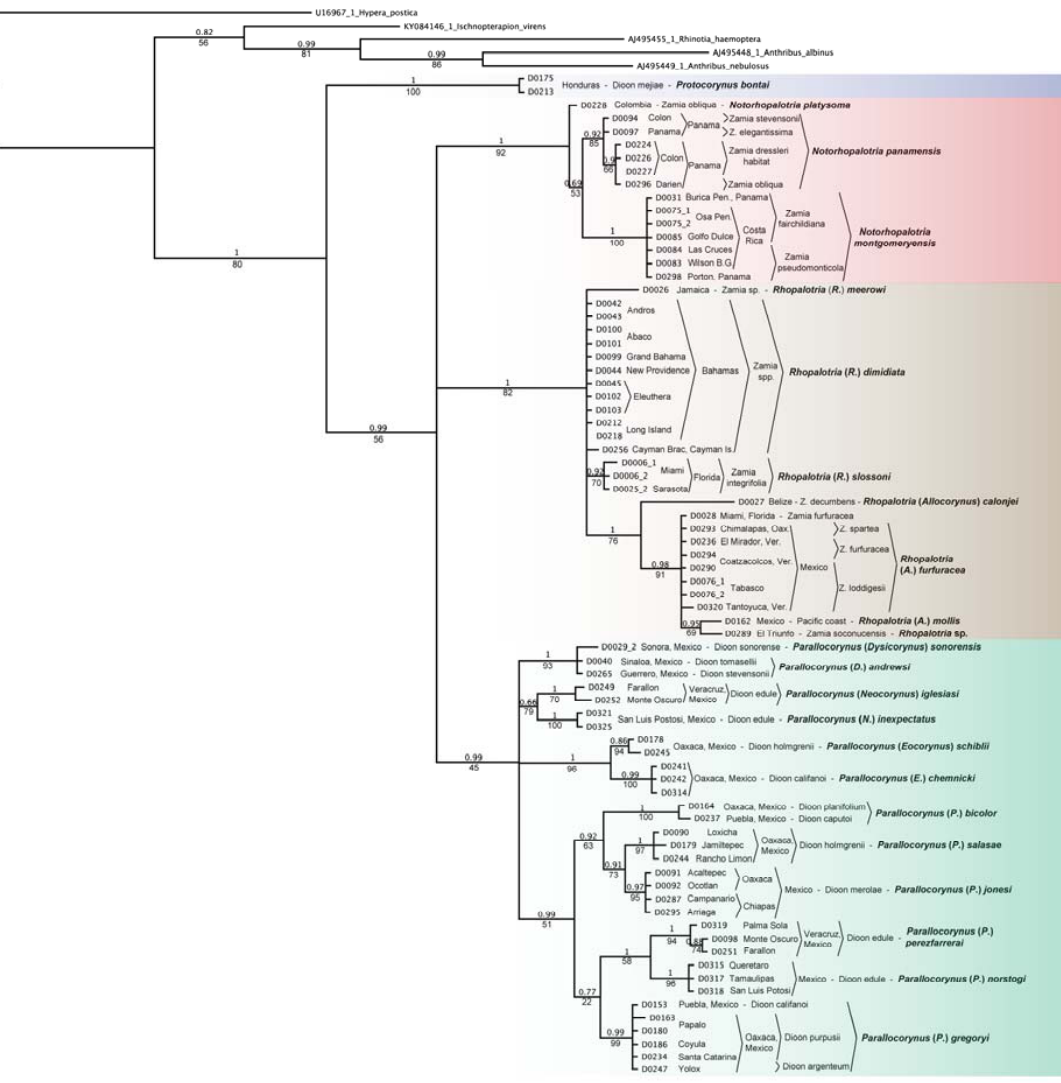
Figure 3. Phylogenetic tree for the Allocorynina synthesized from maximum likelihood (ML) and bayesian inference (BI) analyses of 16S ribosomal RNA (rRNA) gene sequences; numbers above the branches are posterior probabilities from Mr Bayes and the numbers below the branches are bootstrap support from RAxML. Localities and host cycad species are indicated for each sample.